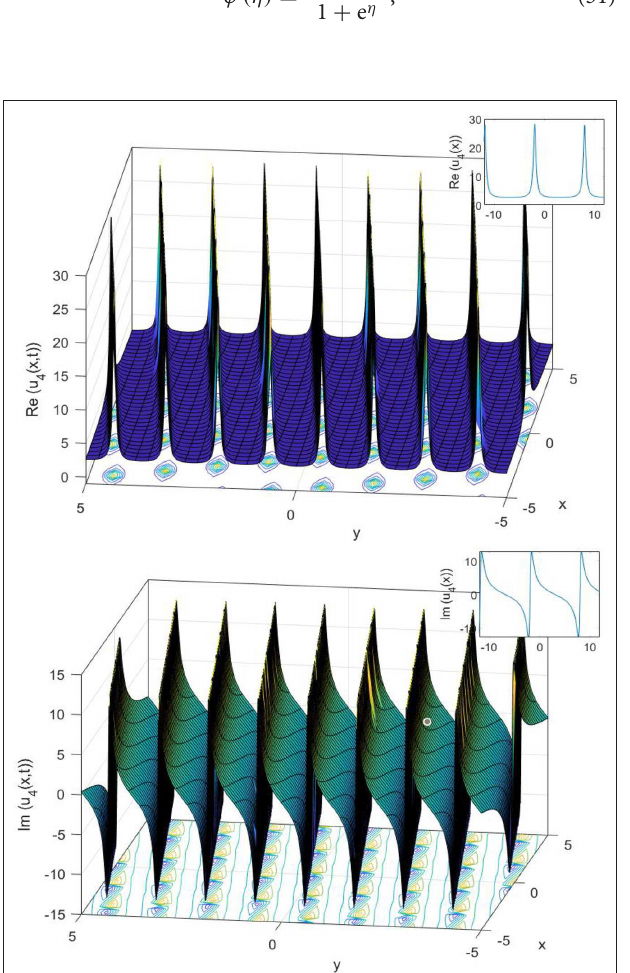
FIGURE 5 | The 3D, 2D, and contour surfaces of Equation (27), using µ 0.4, α 0.1, ǫ 0.5, C 1 2, and a 1 = = = =